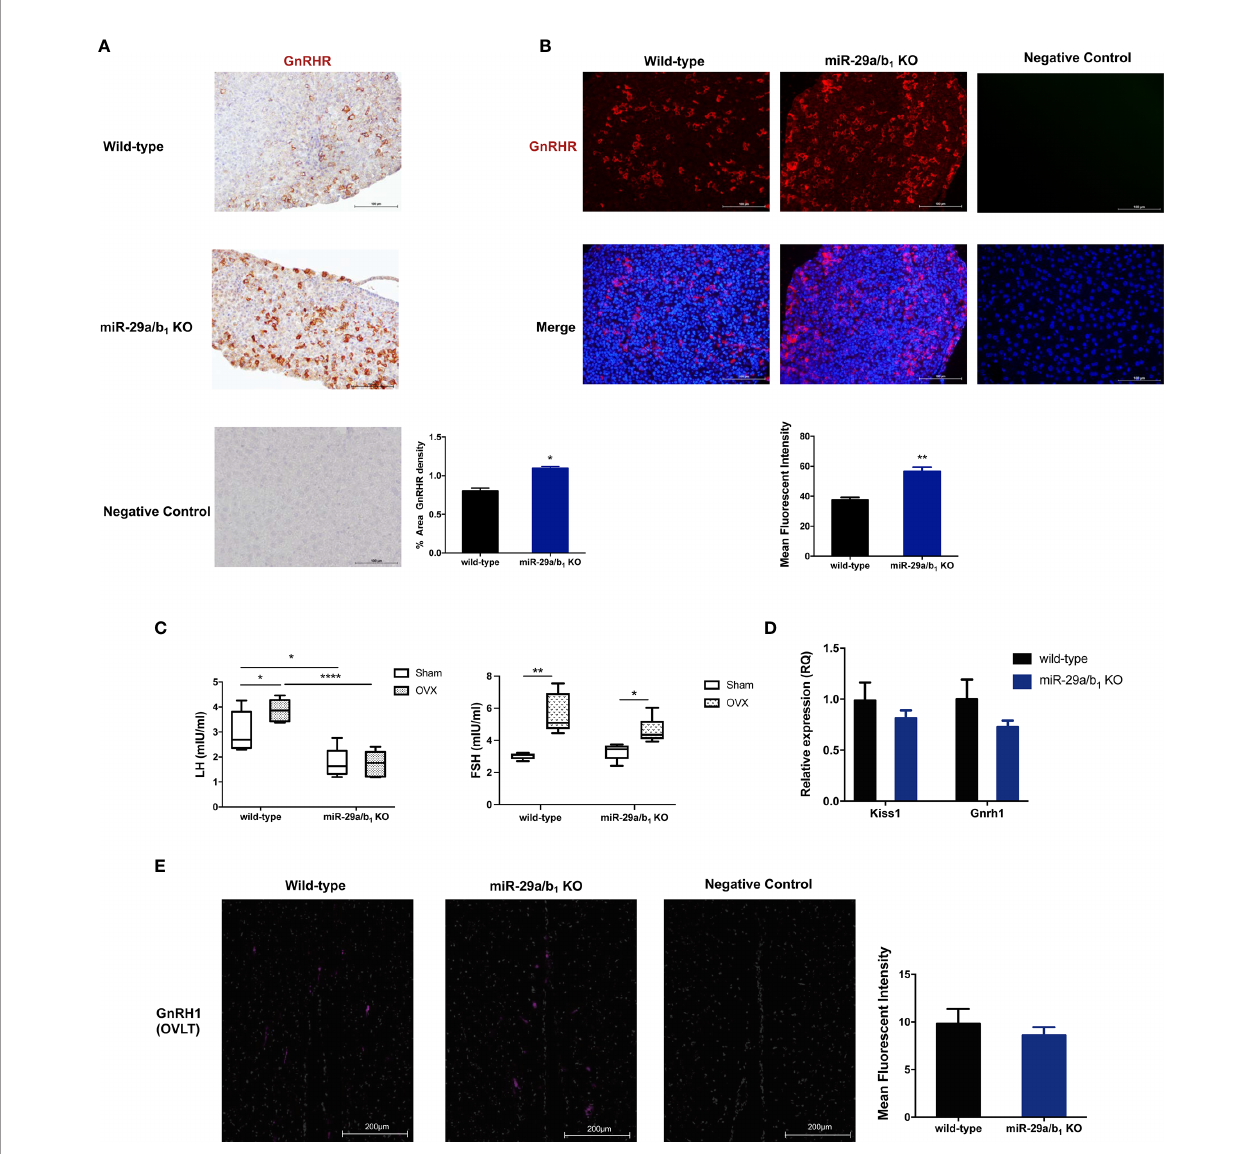
FIGURE 5 | Central mechanism in miR-29a/b 1 KO mice. (A, B) GnRHR immunoreactivity in pituitary of wild-type and miR-29a/b 1 KO females. The receptor was not detectable on the plasma membrane of control. (immunohistochemical: wild-type: 13.43 ± 0.7927, miR-29a/b 1 KO: 25.47 ± 0.534, p=0.0249; immuno fl uorescence: wild-type: 37.79 ± 1.858, miR-29a/b 1 KO: 56.64 ± 2.767, p=0.0045 , n=3). (C) Serum LH and FSH levels in miR-29a/b 1 KO females and controls following ovariectomy (OVX) and sham-operated controls (Sham). (LH: wild-type: p=0.0401 , miR-29a/b 1 KO: p=0.9249 ; FSH: wild-type: p=0.0016 , miR-29a/b 1 KO: p=0.0185 , n=6). (D) Expression of Kiss1 and Gnrh1 in hypothalamus (Gnrh1: wild-type: 1 ± 0.1912, miR-29a/b 1 KO: 0.7287 ± 0.06234, p = 0.1874 , Kiss1: wild-type: 1 ± 0.1305,